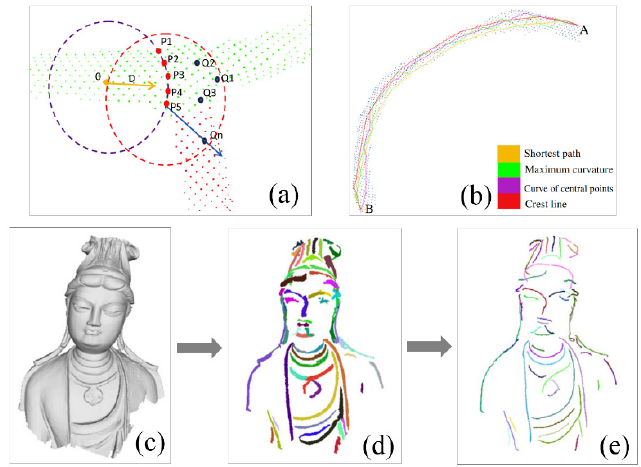
Figure 8. Schematic diagram of curve extraction. ( a ) cluster classification; ( b ) curves extraction from clusters; ( c )source point cloud; ( d )classified clusters; ( e )curves extracted.